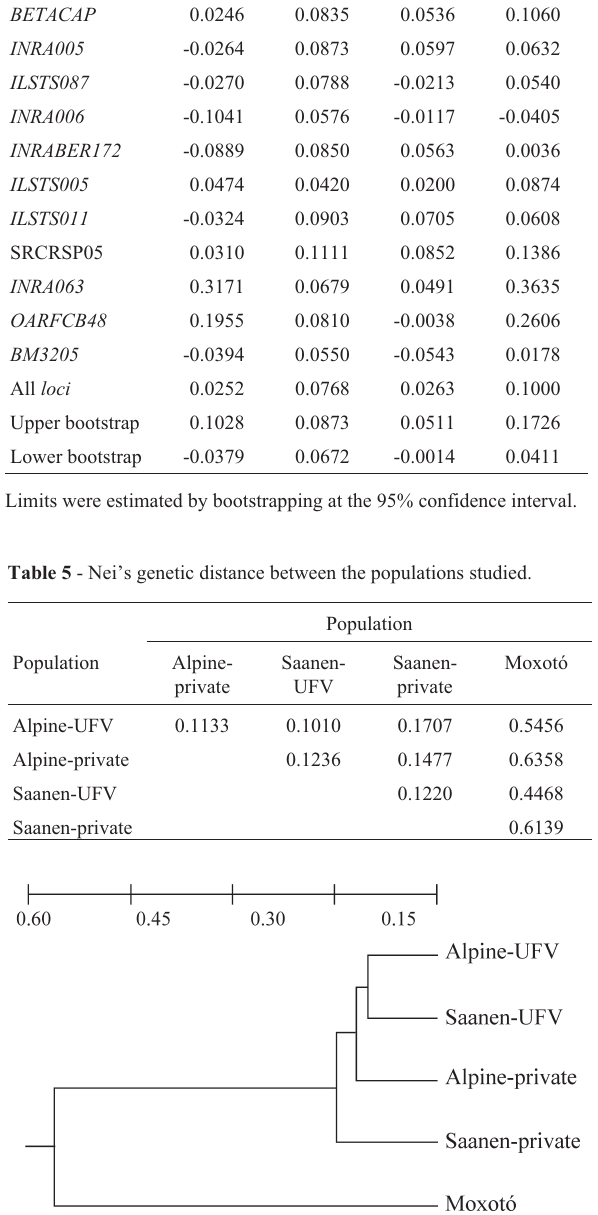
Figure 1 - Genetic distance (D A ) unrooted (UPGMA) dendrogram for the different goat pbased on the. T a